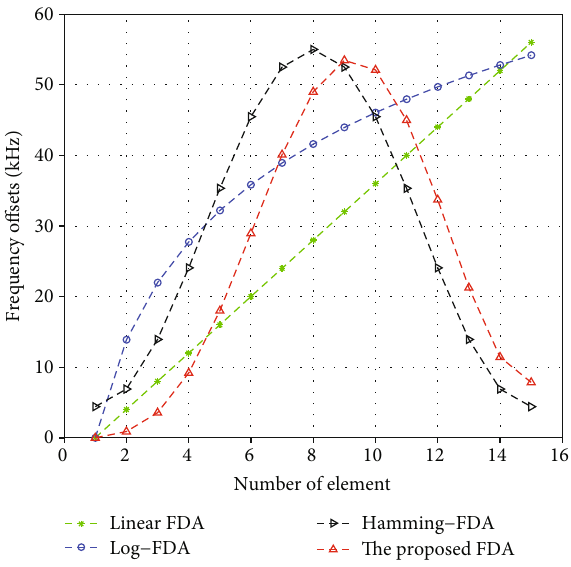
Figure 3: Frequency o ff set